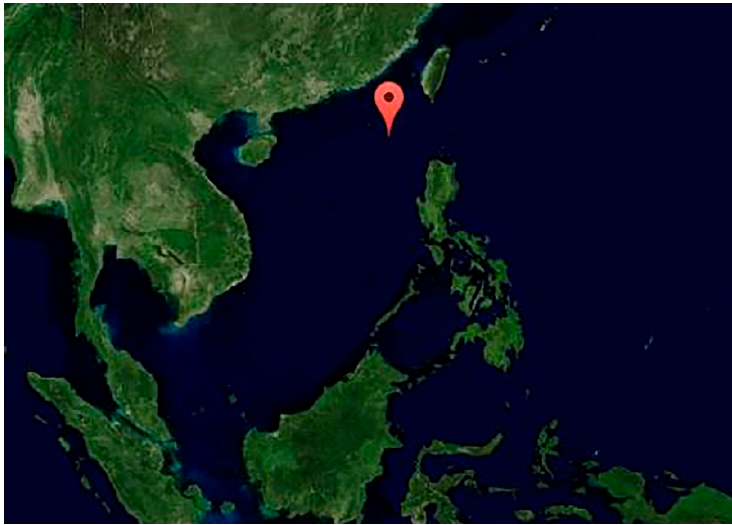
Figure 1. Study area and pipe-laying operation area.